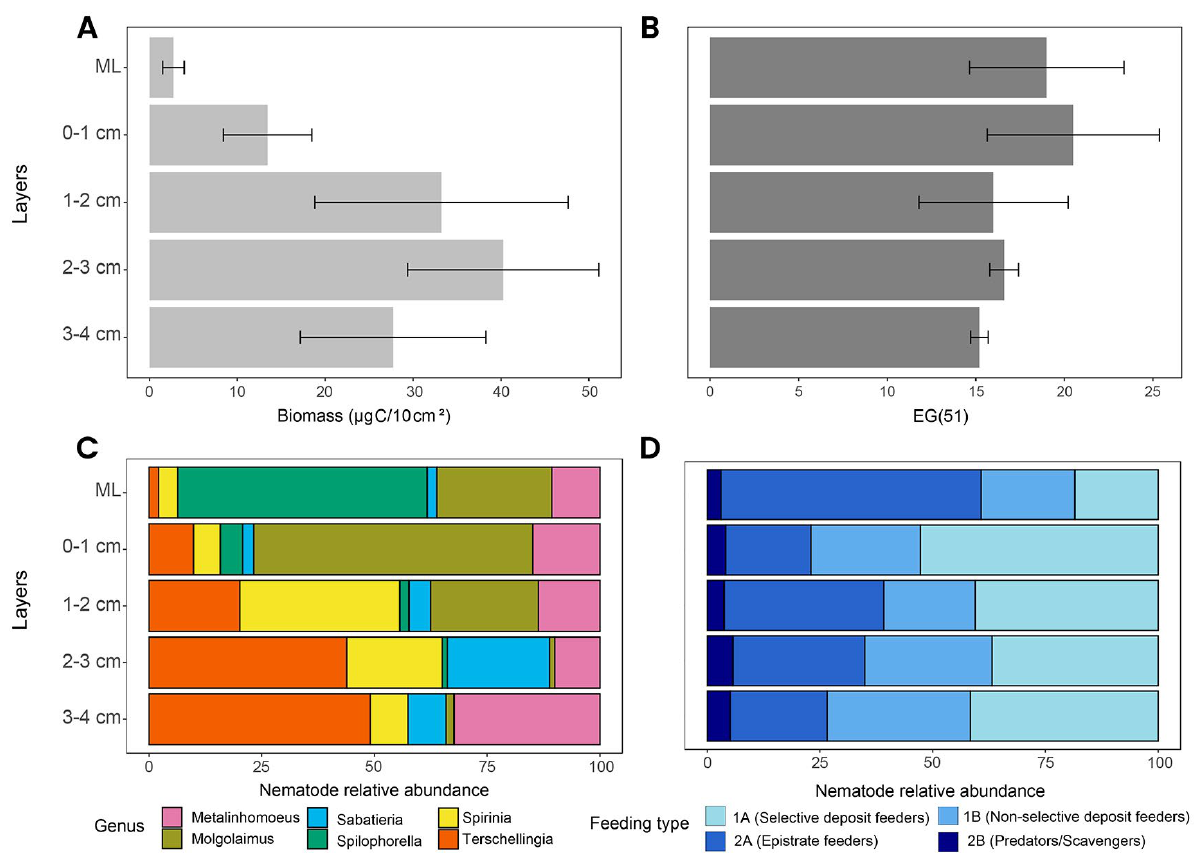
Fig. 3. – A. Vertical distribution of nematode biomass. B. Expected genus number (EG (51)). C. Most abundant nematode genera. D. Nematode trophic